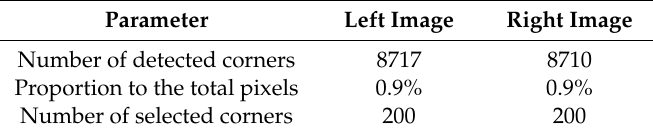
Figure 23. ( a ) Harris corner strength of the target object; and ( b ) CDF plot for the positive Harris corner strength in the out-of-water environment (white indicates positive values, whereas black signifies negative values). Table 11. Results of Harris corner detection performed on target object in the underwater environment.